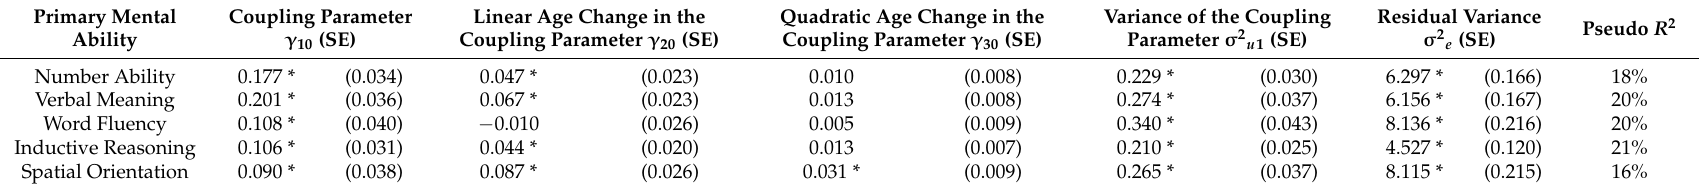
Table 2. Multilevel model examining age-related change in the within-person coupling of primary mental abilities and psychomotor speed. Primary Mental